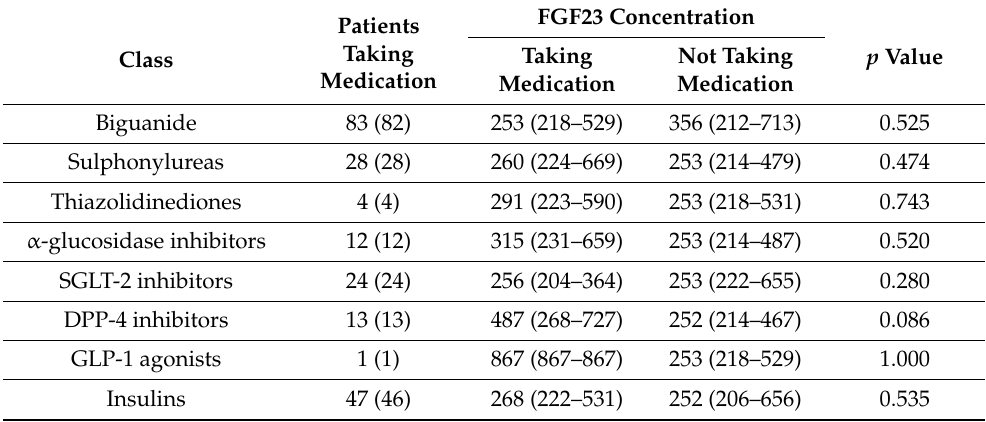
Figure 6. Correlation between LVMI and FGF23 level in patients with long-standing type 2 diabetes mellitus. Abbreviations: LVMI, left ventricular mass index; FGF23, fibroblast growth factor 23. Table 4 gathers data on diabetes medications prescribed by a diabetologist. According to our results, none of the medication groups were associated with the FGF23 level. Table 4. FGF23 concentration versus use of medications for diabetes mellitus.